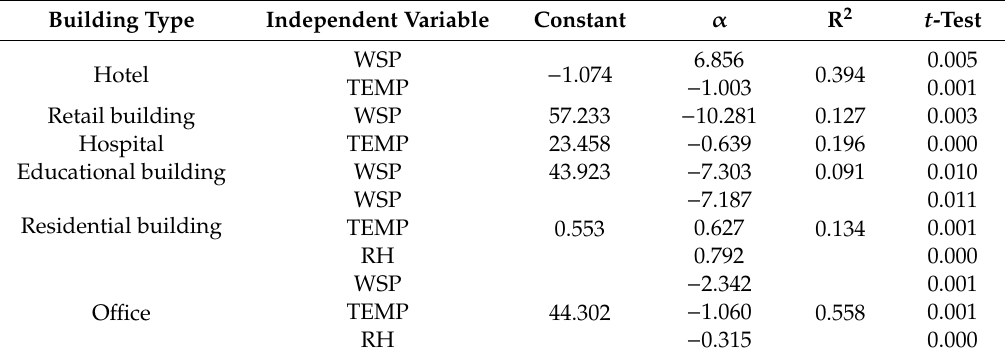
Table 8. Stepwise regression result and t -test of climatic